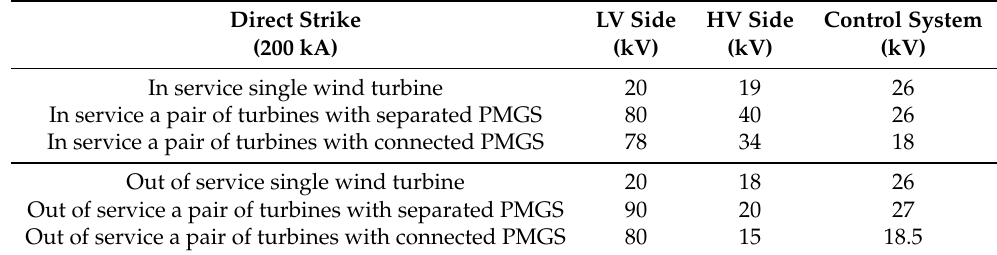
Table 2. Peak voltage values of LV/HV sides of boost transformer and control circuit with direct